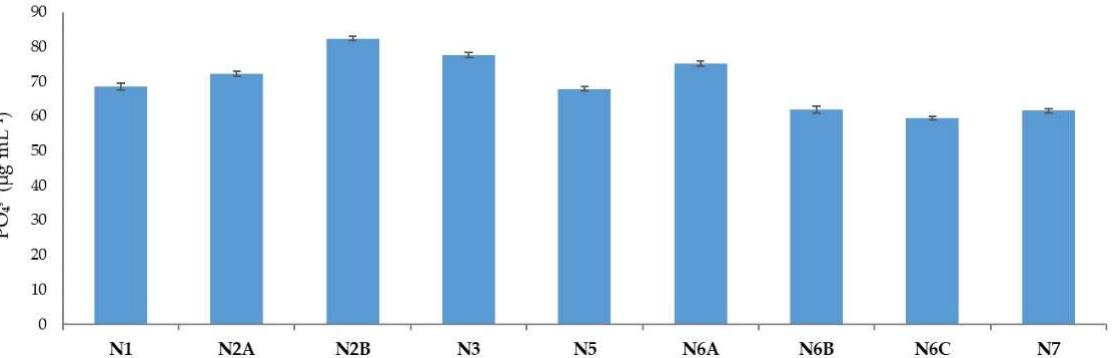
Figure 7. Amounts of solubilized phosphate (PO 43− ) by different isolates cultivated on liquid NBRIP medium.